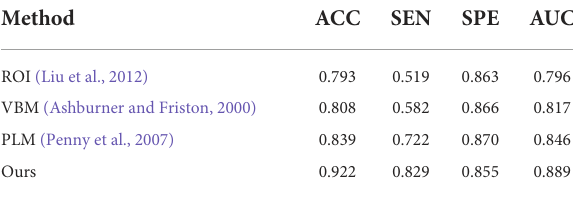
TABLE 3 Comparison of our method with previous machine learning studies (AD progression detection based on the ADNI dataset).